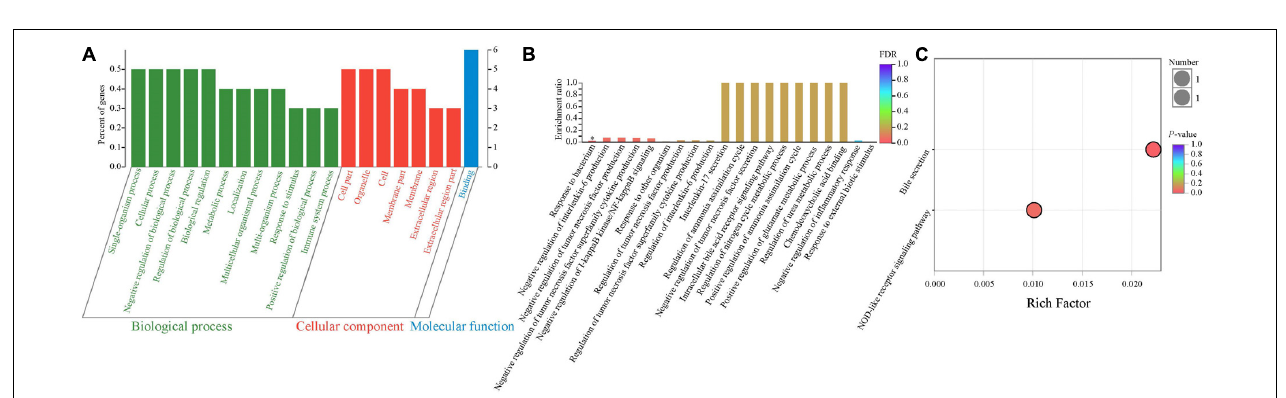
FIGURE 2 | Reverse transcriptase–quantitative polymerase chain reaction validation of the selected genes. Data are shown as mean ± SEM. ∗ P < 0.05, ∗∗∗ P < 0.001. n = 9 per group. NBW, normal body weight; IUGR, intrauterine growth restriction.